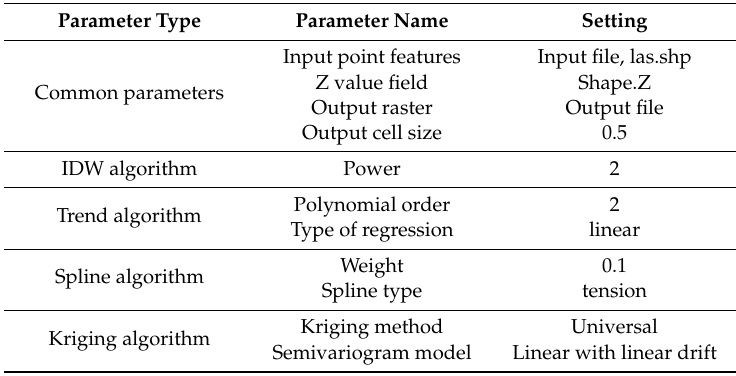
Table 3. The parameters used for the interpolation methods.